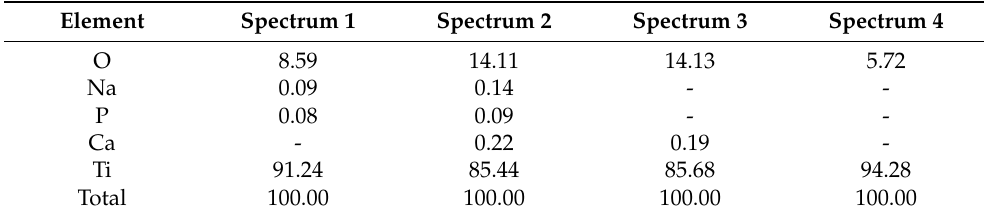
Table 6. Elemental composition on different spots (position 1–4) on surface CP Ti after impedance measurements in PBS solution.